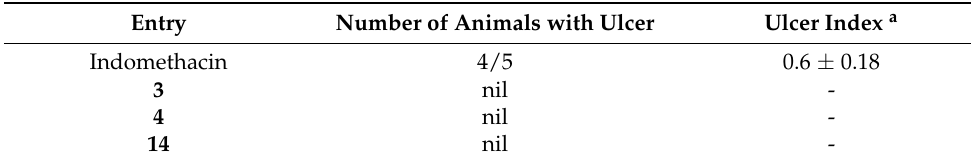
Table 2. Ulcerogenic activity of indomethacin and the tested derivatives 3 , 4 and 14 . Entry Number of Animals with Ulcer Ulcer Index a Indomethacin